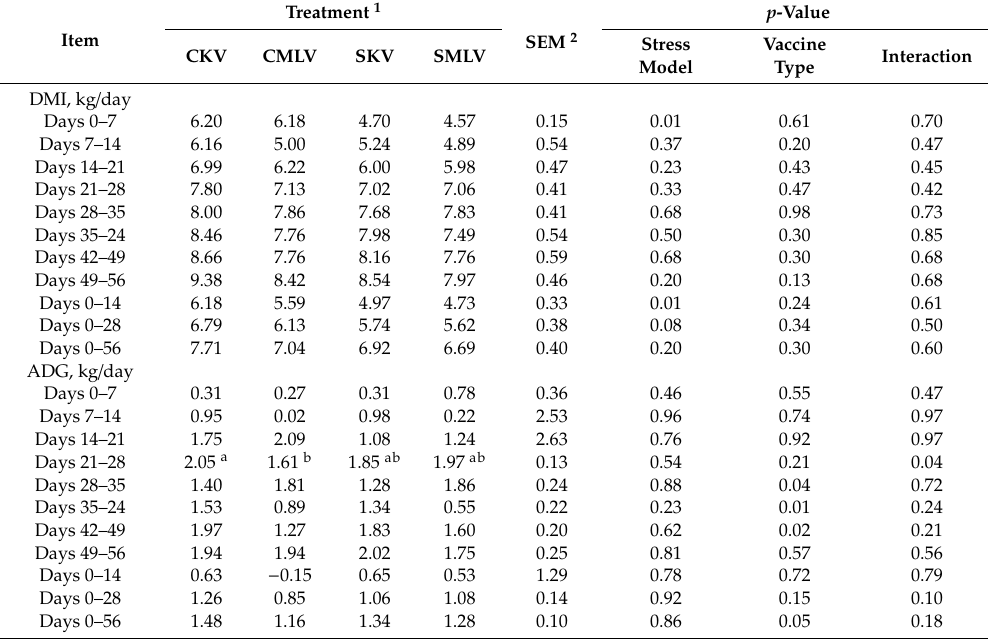
Table 1. E ff ect of stress model and killed or modified-live virus vaccination on feed intake and performance of beef